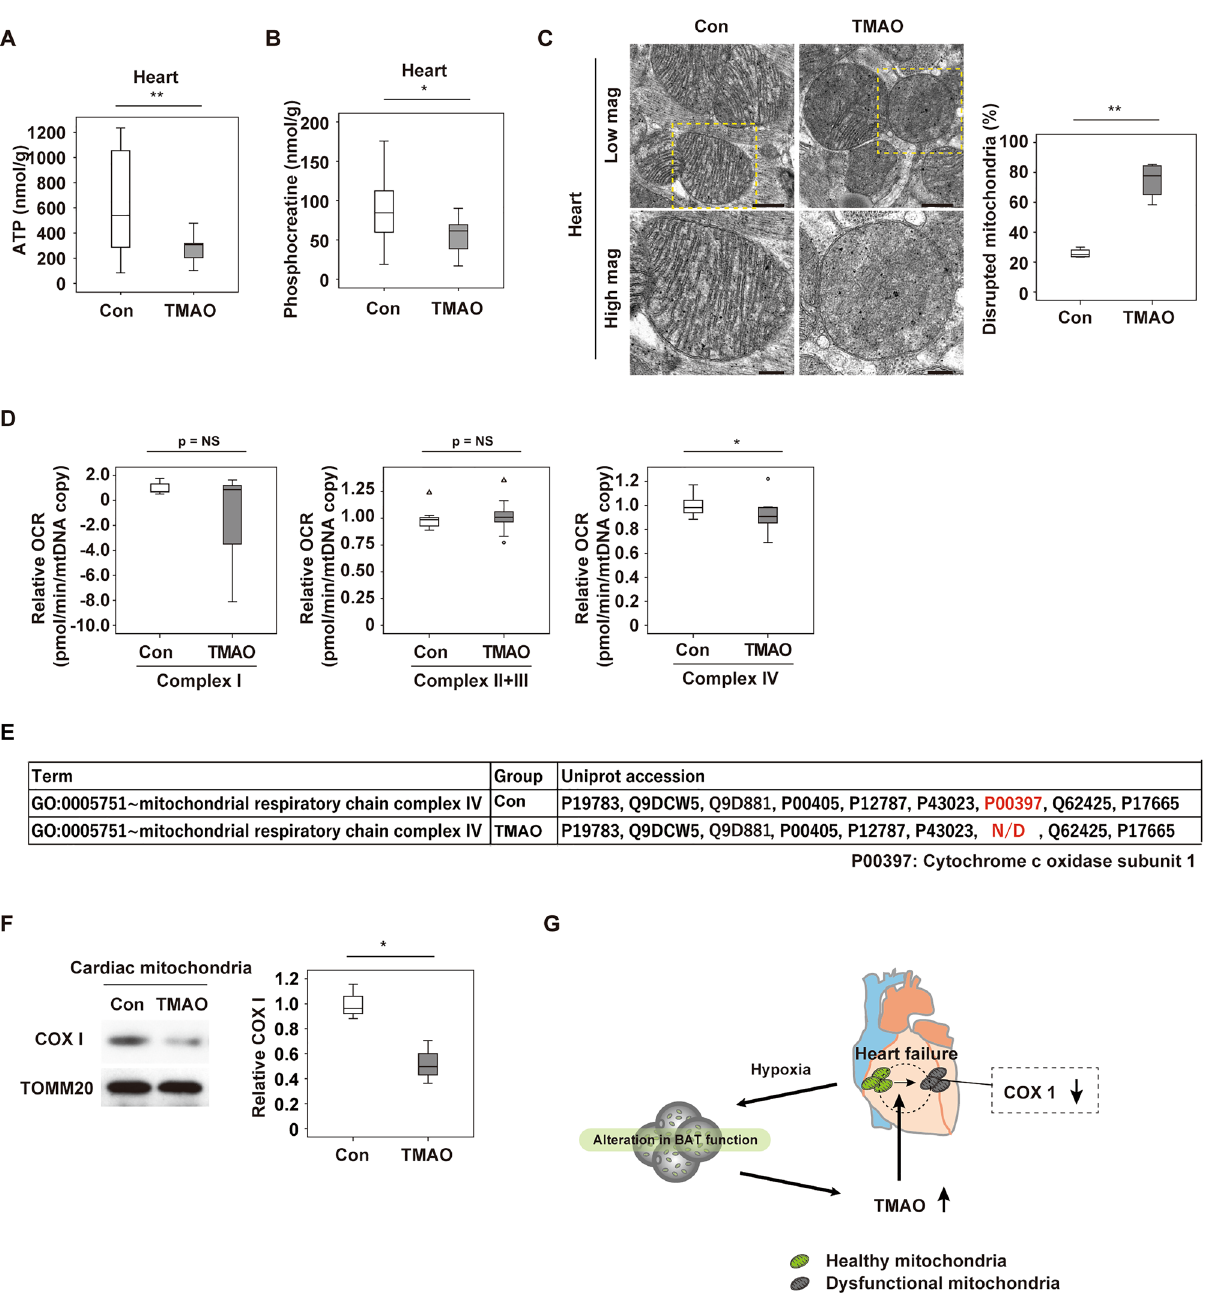
Figure 5. Trimethylamine N-oxide inhibits mitochondrial respiration in the heart. ( A , B ) Metabolomic study analysing ATP ( A ) ( n = 24, 11) or phosphocreatine ( B ) ( n = 24, 11) in the hearts of WT mice administered PBS (Con) or Trimethylamine N-oxide (TMAO) for 2 weeks. ( C ) Transmission electron microscopy of cardiac tissues from mice prepared as described in Fig. 5A. The right panel shows quantification of the disrupted mitochondria ( n = 4, 4). Scale bar = 500 nm for low magnification and 200 nm for high magnification. ( D ) Oxygen consumption rate (OCR) assessing respiration by the indicated complexes in mitochondria isolated from the cardiac tissues of mice prepared as described in Fig. 5A ( n = 7, 9). ( E ) Mitochondrial complex IV proteins of cardiac mitochondria assessed by mass spectrometry in the PBS (Con) or TMAO treated WT mice. N/D = Not detected. ( F ) Western blot analysis of COX1 in cardiac mitochondria prepared as described in ( E ). TOMM20 was used as the loading control. The right panel shows quantification of the data ( n = 3, 3). Original blots are presented in Supplementary Fig. 9. ( G ) Graphical abstract showing a summary of the findings. Data were analyzed by the 2-tailed Student’s t-test ( A , B , C , D and F ). *P < 0.05, **P < 0.01. Values represent the mean ± s.e.m. NS not